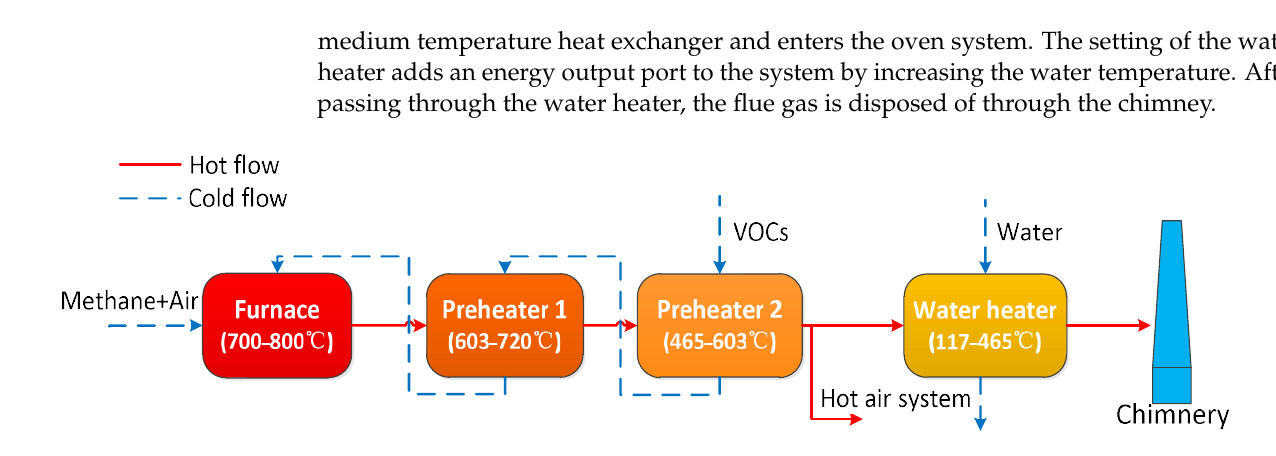
Table 1. Feeding parameters.